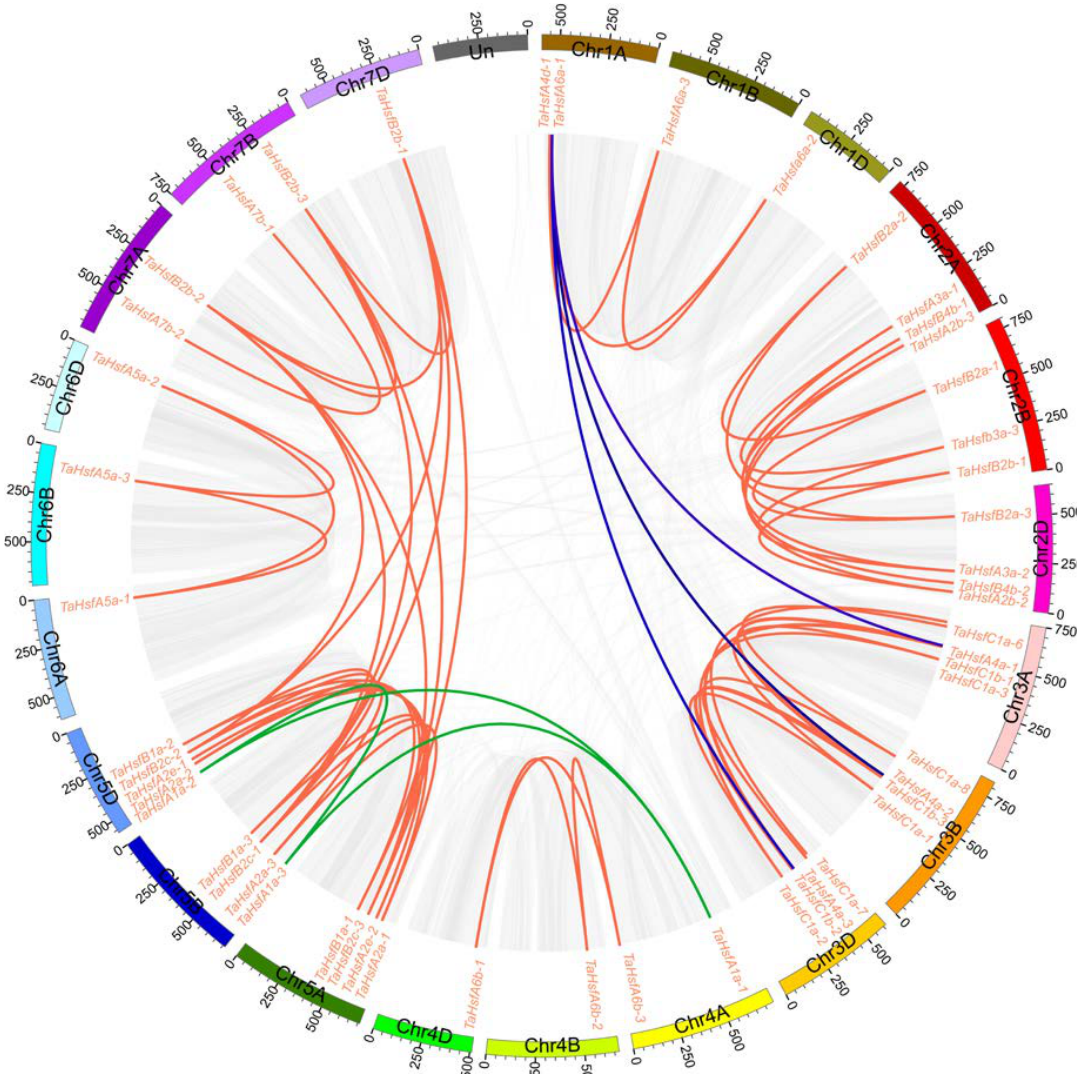
Figure 3. Genomic locations of Hsfs and segmental duplicated gene pairs in the wheat genome. Gray lines in the background indicate the synteny blocks within the whole wheat genome, and red lines denote the segmental duplication HSF gene pairs. The blue lines show genes that have undergone segmental duplication with TaA4d-1 , while the green lines show the genes that have undergone segmental duplication with TaA1a-1 .